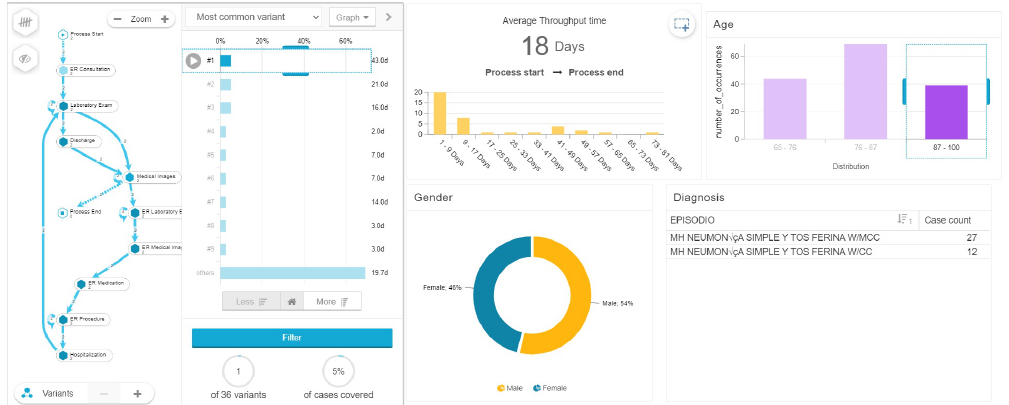
Figure 7. Length of stay of patients between 76 and 87 years of age.